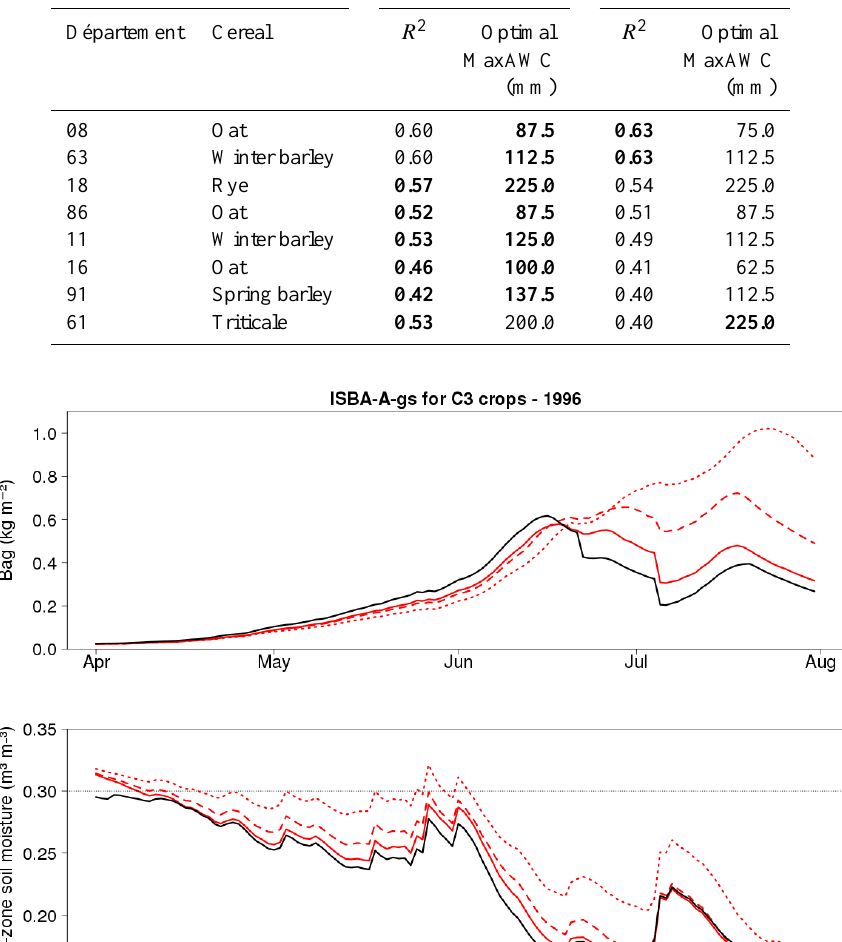
and Agreste for FR-2L and DIF1 simulations at départe- X values and the yields of Agreste statistics are X